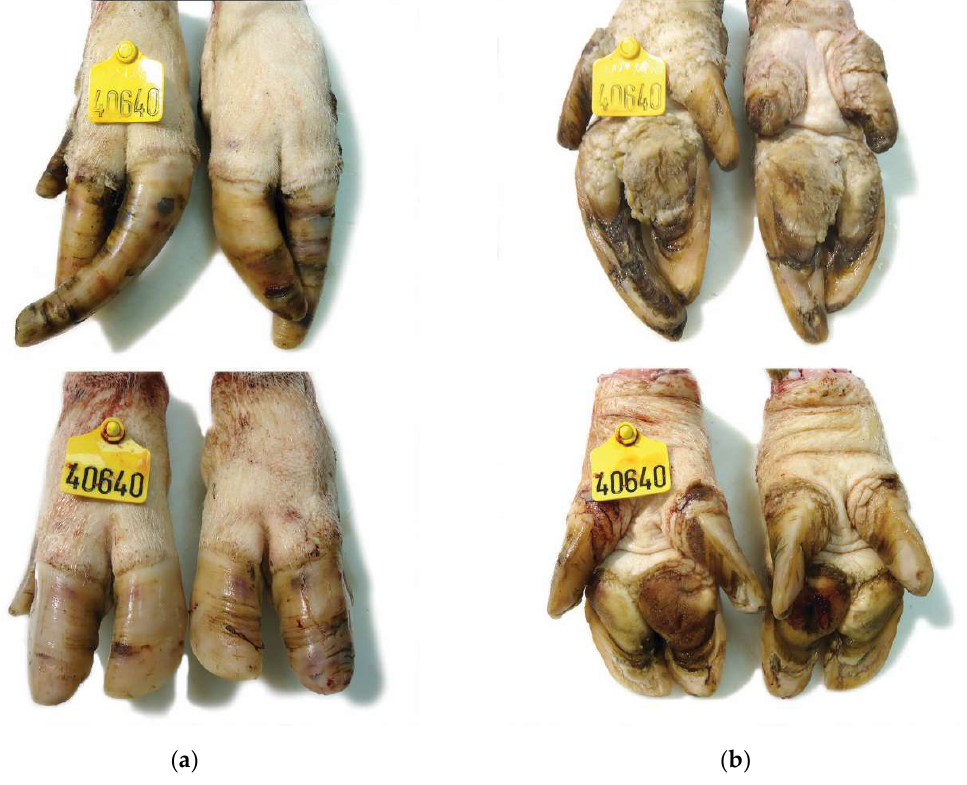
Figure 5. Claw lesions from a culled sow of genetic line A (PIC): ( a ) Dorsal view: Superficial cracks and erosions on the hoof wall of front limbs (bottom). Elongated and deformed claws of the hind limbs (top). The hoof wall is rough with ridges, cracks and bruises; ( b ) Ventral view: Extensive solar cavitation and hyperkeratinization and ulceration of the heel bulbs.